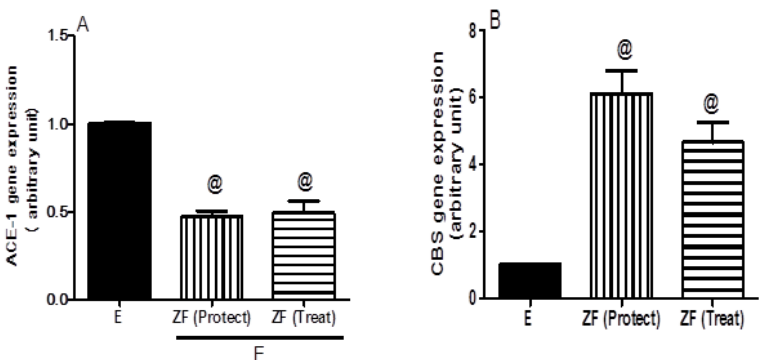
FIGURE 3 - Effect of ZF on intratumoral gene expression of ACE-1 and CBS